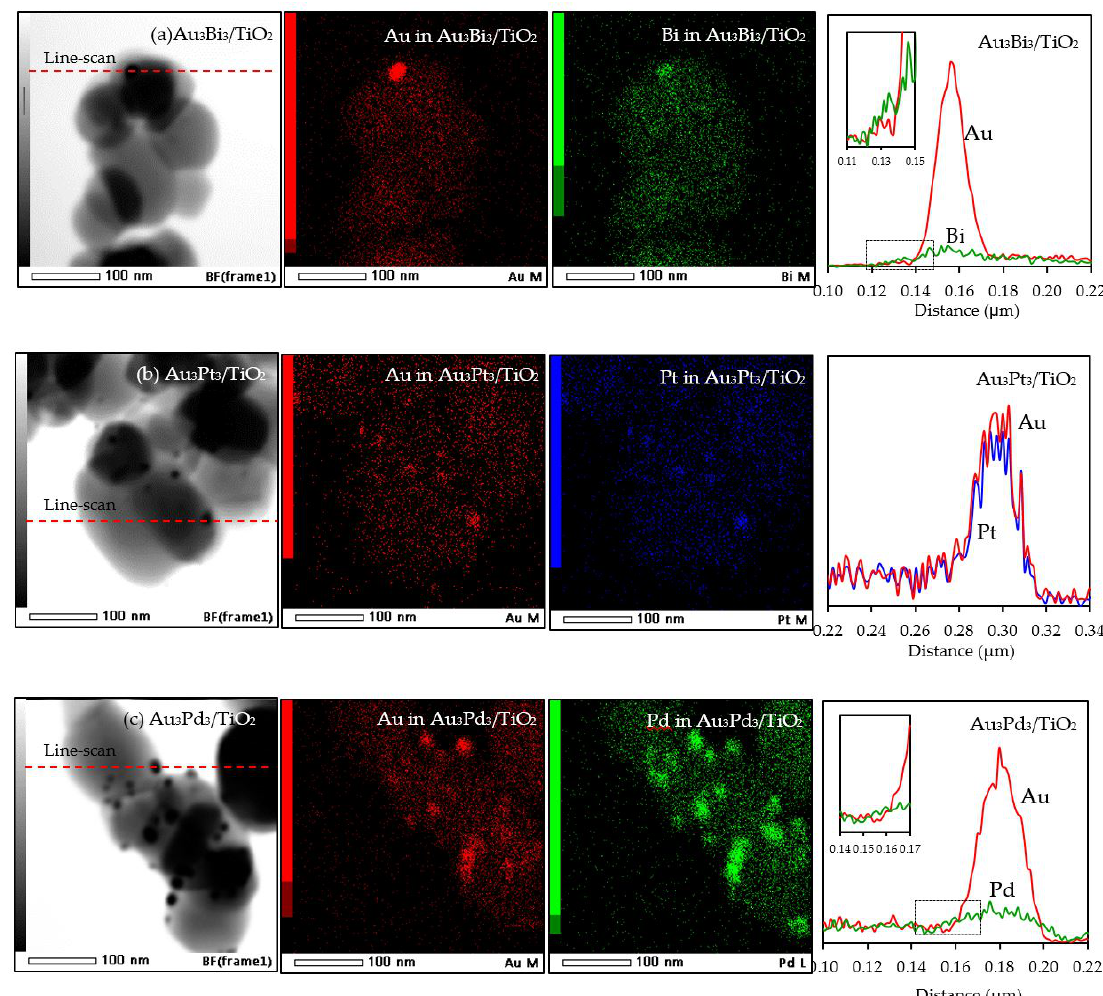
Figure 10. Representative TEM–EDS mapping images and line-scan profile of the different of Au 3 M 3 /TiO 2 photocatalysts.